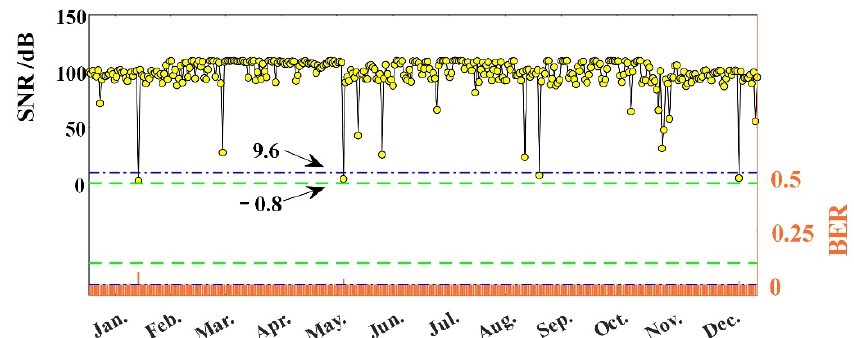
Figure 9. The SNR and BER of periods from 12 to 13 o’clock in the Taiwan Strait during